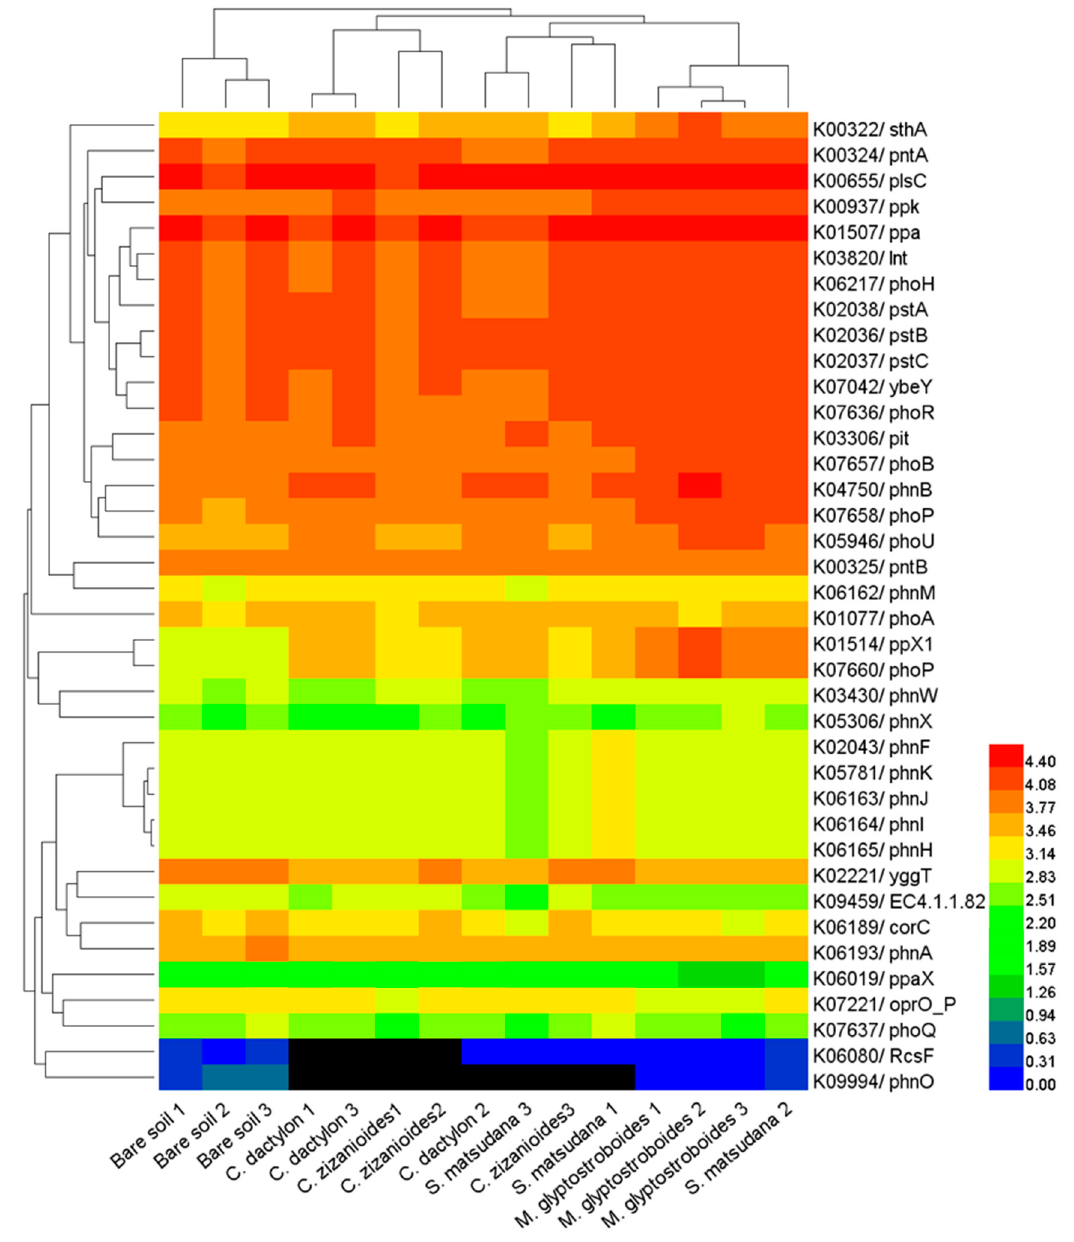
Figure 10. A heatmap showing the hierarchical clustering of the P metabolism related KOs based on predicted gene copy (log10 transformed) of bacterial microbiota across all samples. The digital number represents three biological replicates for each sample.